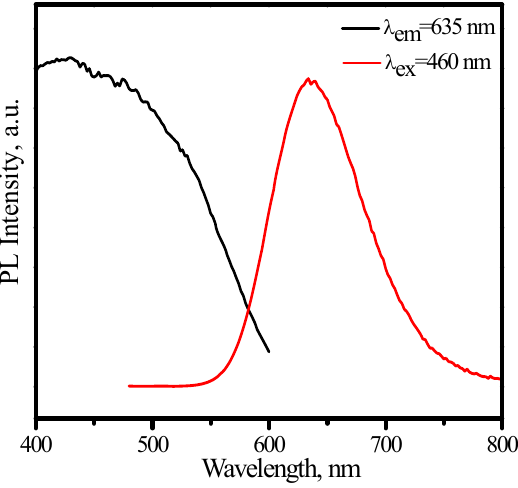
= 460 nm) spectra of (Sr ex